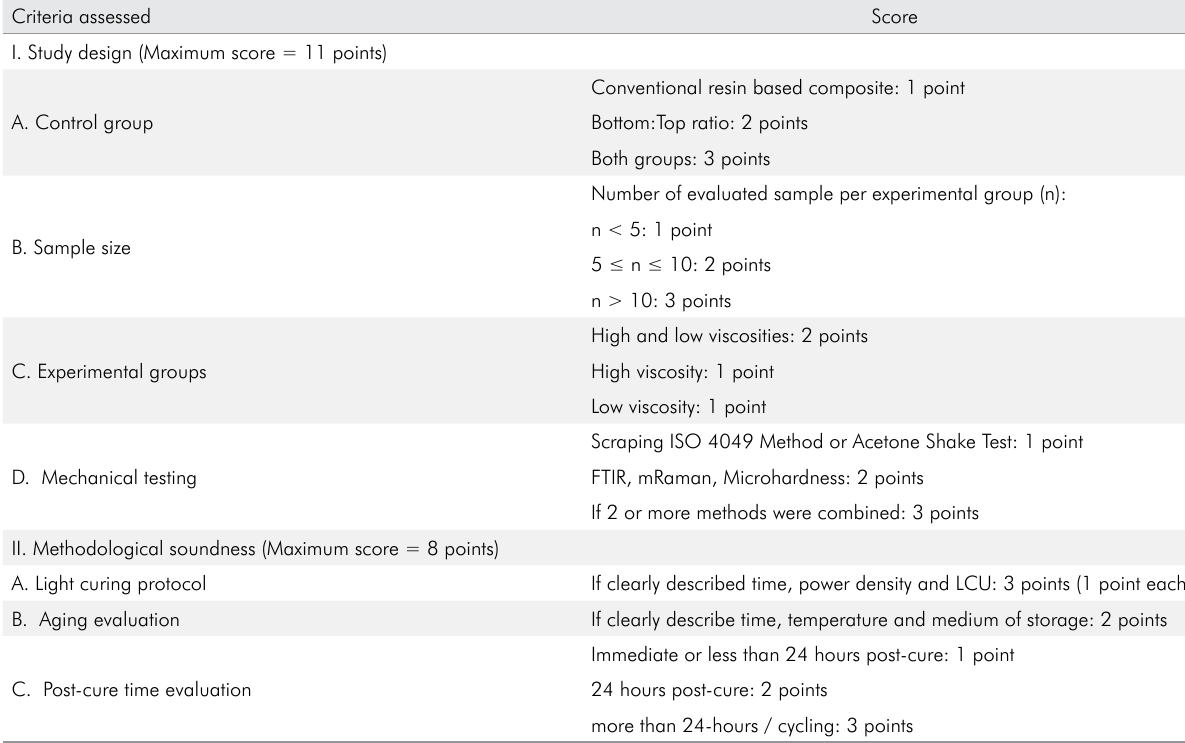
Table 2. Methodological scoring